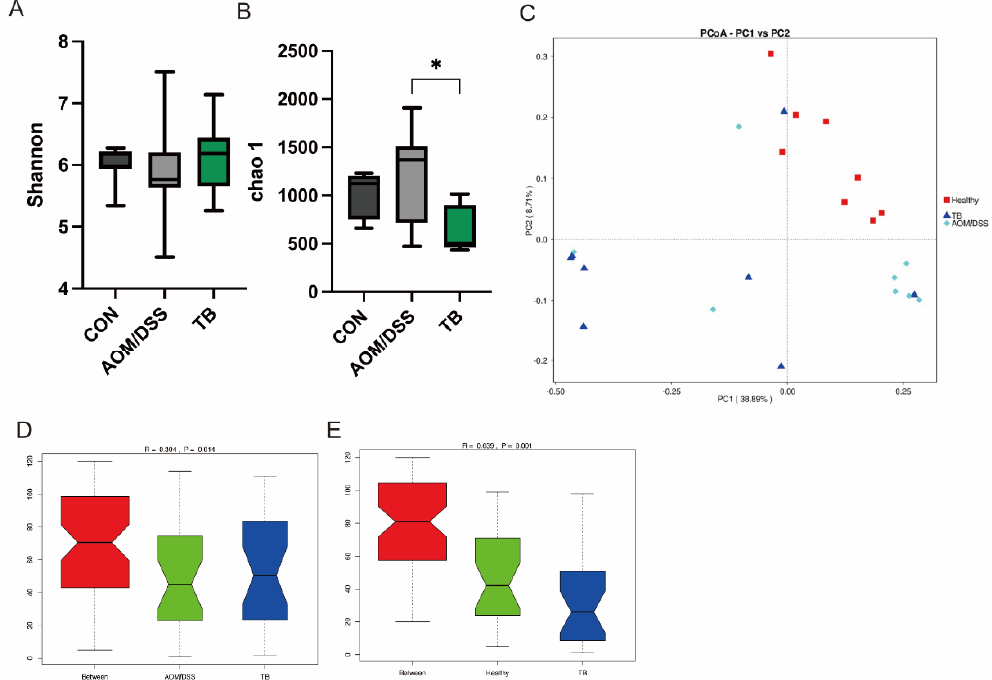
Figure 4. TB regulated gut microbiota diversity. Alpha diversity indices: ( A ) chao1 index, ( B ) Shannon index, ( C ) Weighted Unifac Principal Coordinates Analysis (PcoA). ANOSIM analysis between ( D ) AOM/DSS and TB, ( E ) CON and Tb. n = 7–8 per group. * p < 0.05.